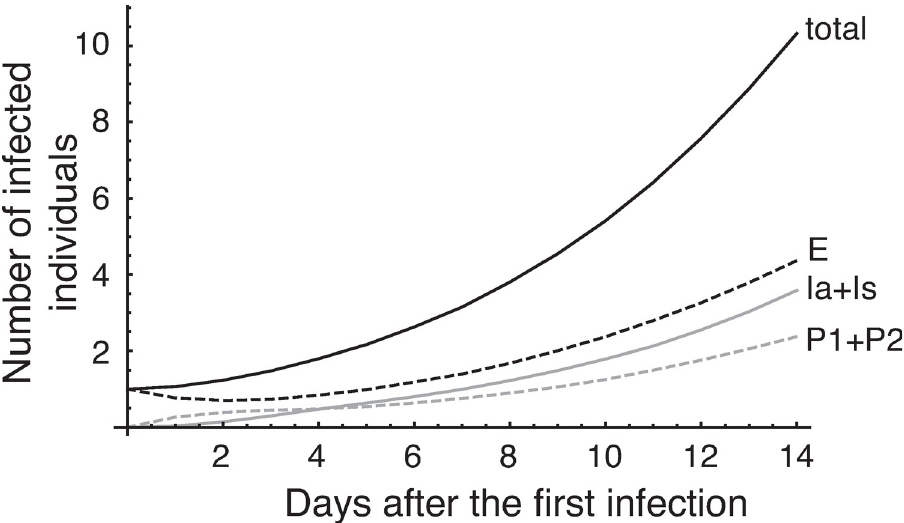
Fig 1. Infection dynamics without any countermeasures. The initial values are S (0) = 99, E (0) = 1, and the others are 0. The average of 10,000 replicates. Total number of infected individuals is the sum of E , P 1 , P 2 , Ia , and Is .